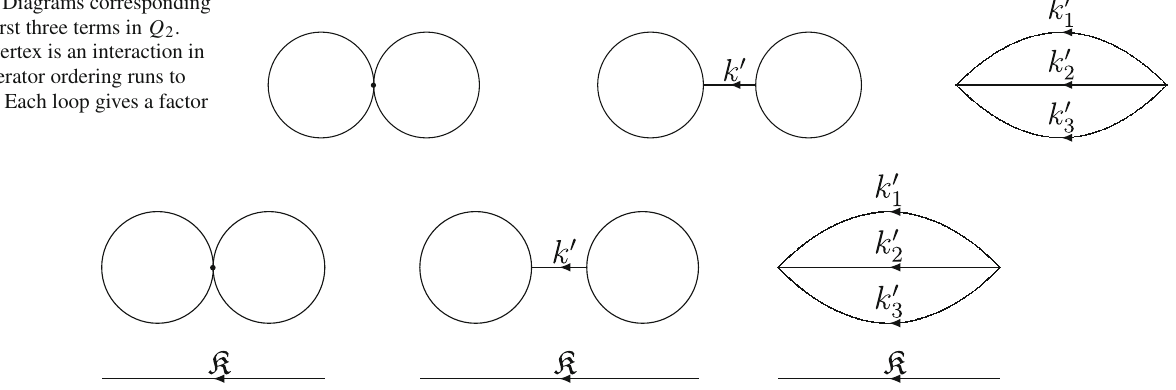
Fig. 2 Diagrams corresponding to the first three terms in the Q 2 2 πδ( k 1 − K ) contribution to E 2 . The k 1 = K line is disconnected from the diagram. Therefore these are just contributions to the ground